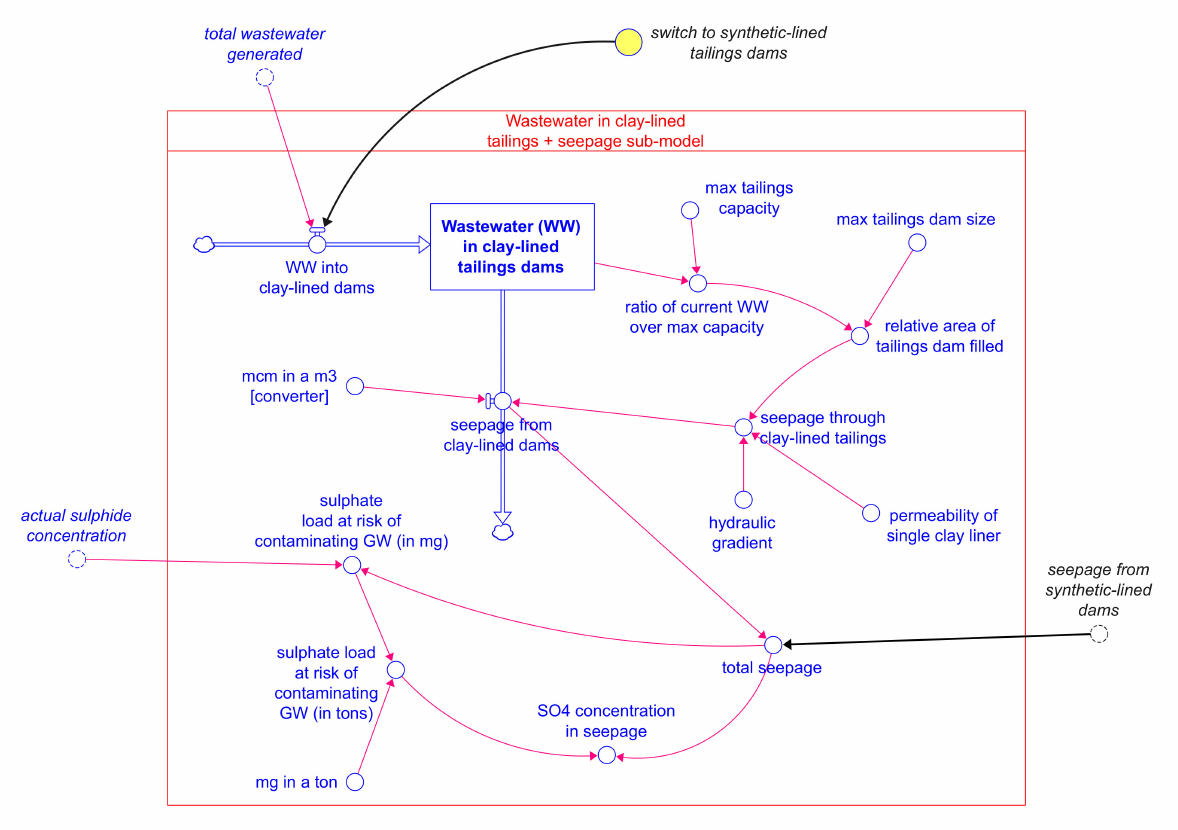
Figure 4. Sub-model 2 represents the wastewater in clay-lined tailings dam and seepage